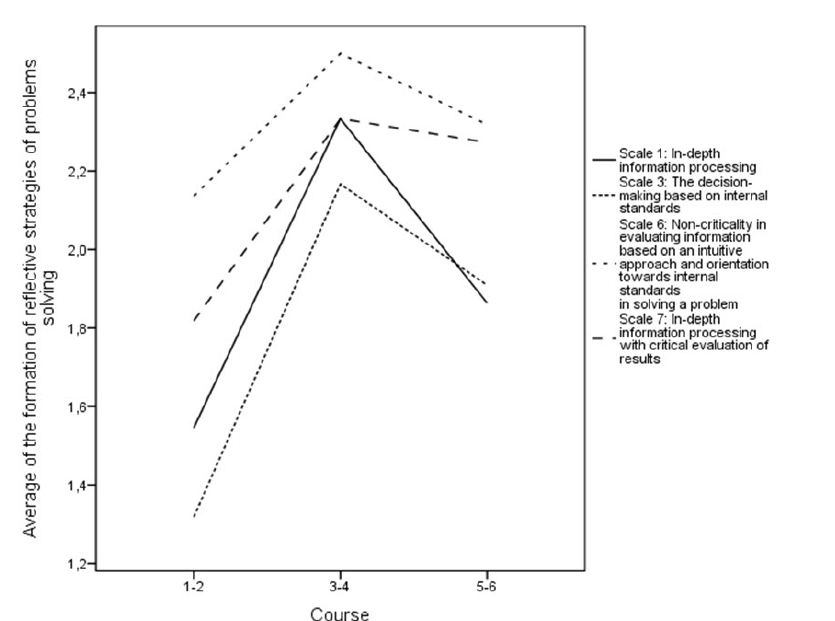
Figure 3. The results of the method “The reflexive strategies of problems solving” (O. Savchenko, M. Makiienko) in the development among students in accordance with the curriculum with the use of